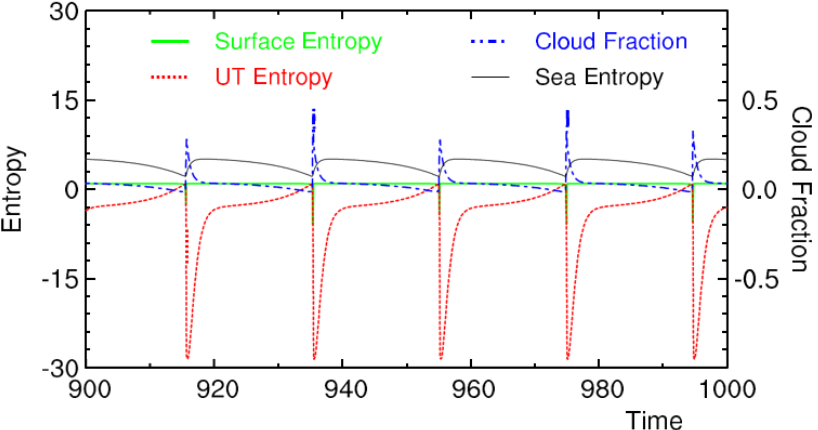
Figure 16. Time series of (green) the dimensionless air surface entropy X , (red) the UT entropy Y , (blue) the UT cloud fraction Z and (black) the sea surface entropy Ψ in the system of Equations (28), (29), (19) and (20) (see Appendix B for the definitions and parameters used). The horizontal axis of time is scaled with 2𝜏 𝑡 = 28 days (or ~1 month) as the unit.